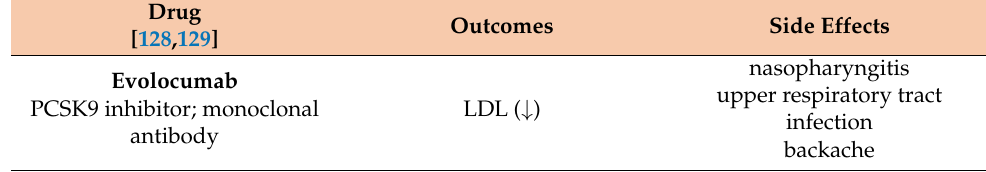
Table 1. PCSK9 inhibitors and PPAR agonists approved by